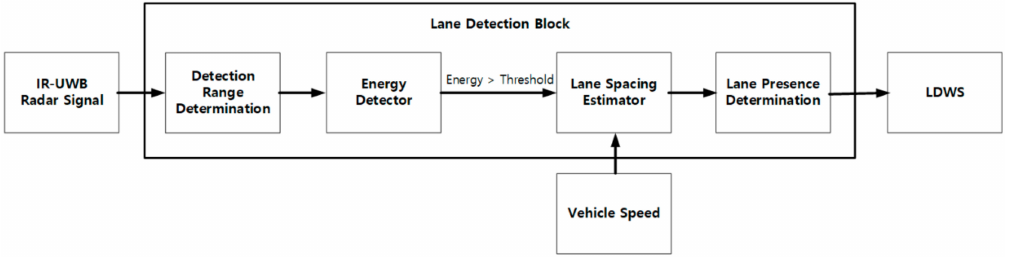
Figure 2. Lane detection method. LDWS: lane departure warning